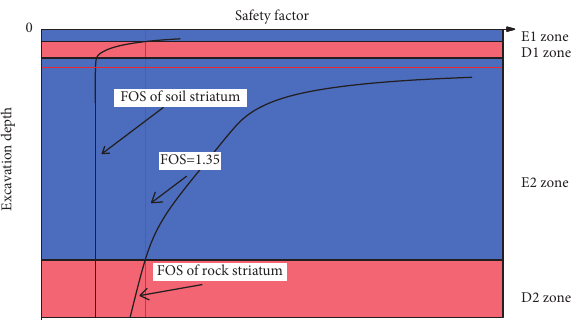
Figure 12: Spatial distribution of foundation pit stability characteristics.